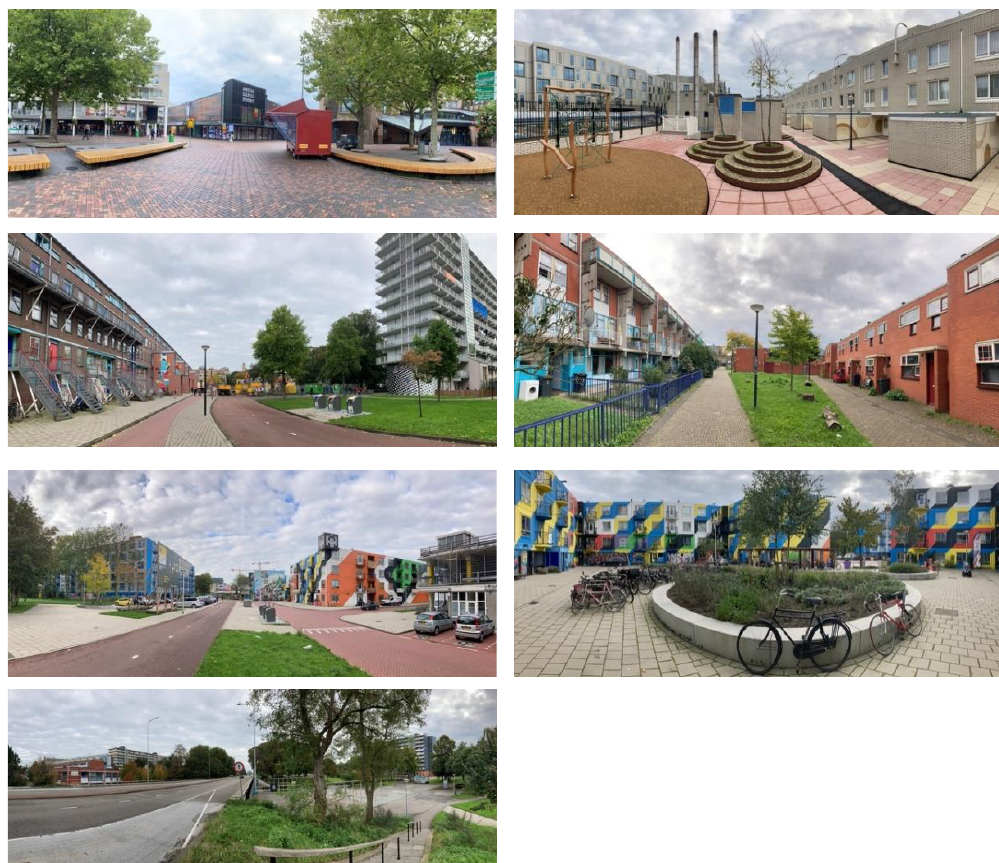
Figure 3. Photoset used for the interviews. Top row : Bijlmerplein, second row : Hoptille, third row : Heesterveld, bottom row : Karspeldreef.